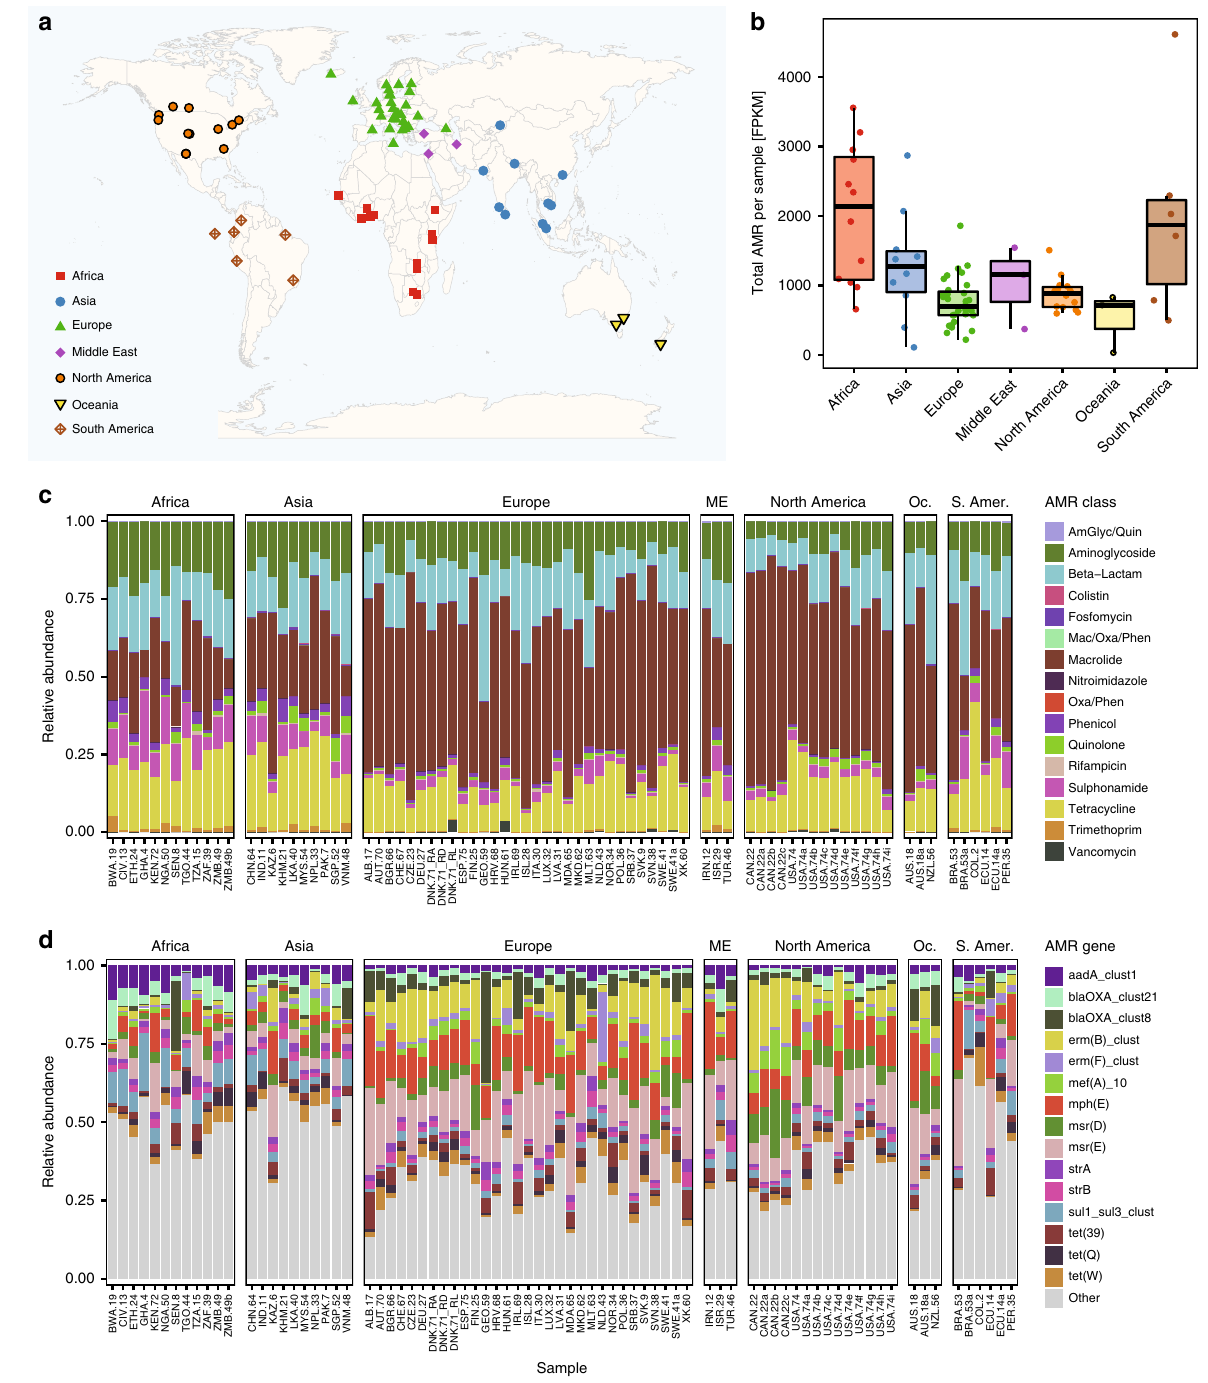
Fig. 1 Global sewage sampling sites and overview of antimicrobial resistance (AMR) abundance and composition. a Map of the sampling sites. b Boxplots of the total AMR fragments per kilo base per million fragments per sample, strati fi ed by region. Each sample is represented by a dot with horizontal jitter for visibility. The horizontal box lines represent the fi rst quartile, the median, and the third quartile. Whiskers denote the range of points within the fi rst quartile − 1.5× the interquartile range and the third quartile + 1.5× the interquartile range. c Relative AMR abundance per antimicrobial class